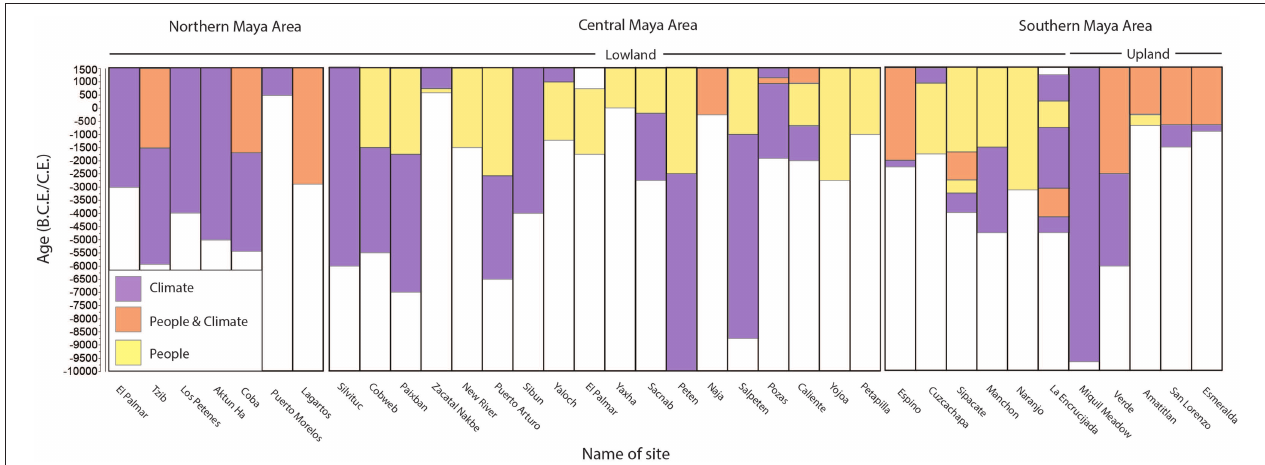
FIGURE 2 | Summary of reported vegetation drivers and impacts to the vegetation from the Maya Area during the Pre–Columbian Holocene, as reported by authors from palynological reconstructions (see Supplementary Information for